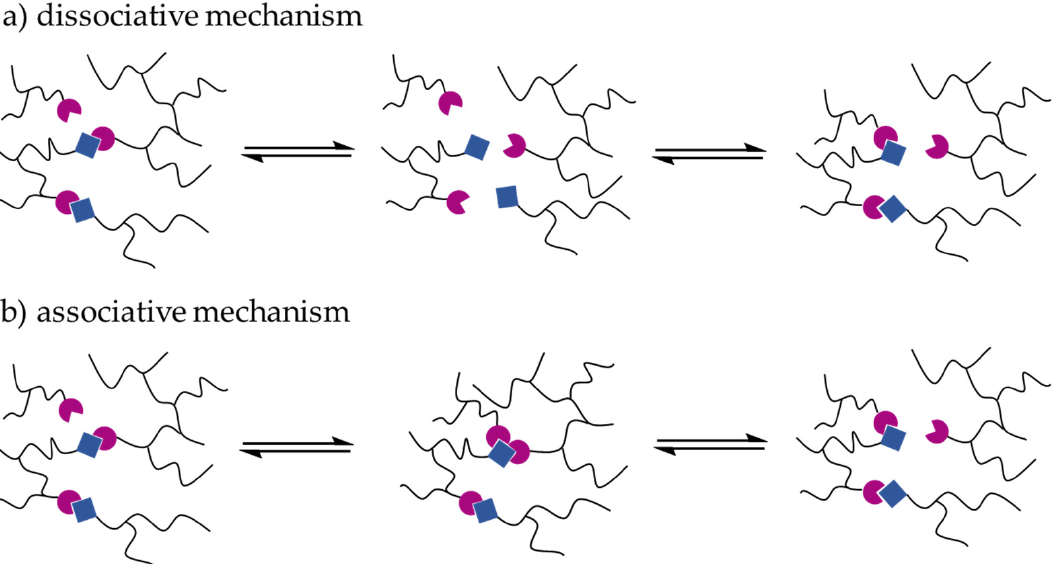
Figure 1. Difference between a covalent adaptable network (CAN) with a dissociative ( a ) and an associative mechanism ( b ). In dissociative CANs, the network loses its integrity while, in associative CANs, an exchange reaction takes place so that the polymer network is kept. The blue-colored and magenta-colored shapes serve to represent the crosslinking points of the CAN.